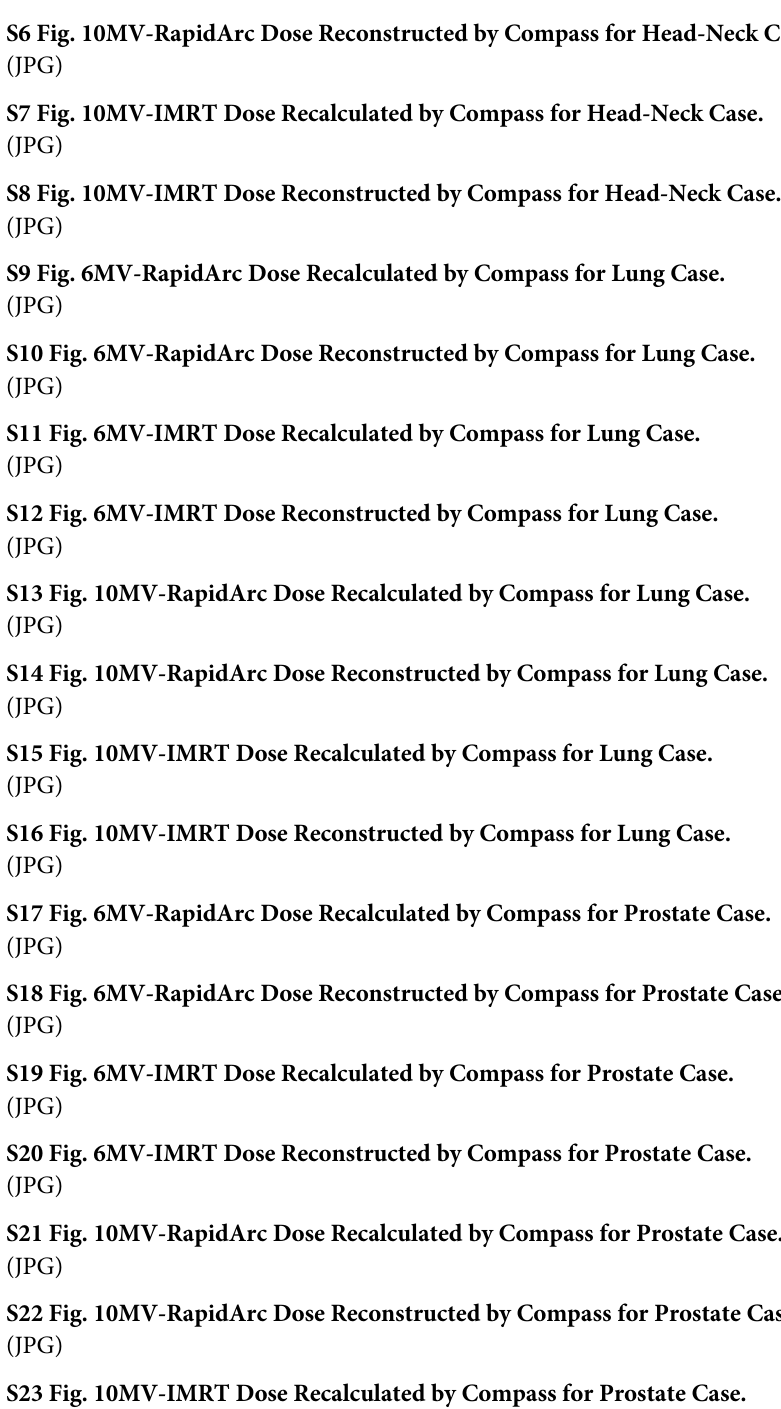
(JPG) S6 Fig. 10MV-RapidArc Dose Reconstructed by Compass for Head-Neck Case. (JPG) S7 Fig. 10MV-IMRT Dose Recalculated by Compass for Head-Neck Case. (JPG) S8 Fig. 10MV-IMRT Dose Reconstructed by Compass for Head-Neck Case. (JPG) S9 Fig. 6MV-RapidArc Dose Recalculated by Compass for Lung Case. (JPG) S10 Fig. 6MV-RapidArc Dose Reconstructed by Compass for Lung Case. (JPG) S11 Fig. 6MV-IMRT Dose Recalculated by Compass for Lung Case. (JPG) S12 Fig. 6MV-IMRT Dose Reconstructed by Compass for Lung Case. (JPG) S13 Fig. 10MV-RapidArc Dose Recalculated by Compass for Lung Case. (JPG) S14 Fig. 10MV-RapidArc Dose Reconstructed by Compass for Lung Case. (JPG) S15 Fig. 10MV-IMRT Dose Recalculated by Compass for Lung Case. (JPG) S16 Fig. 10MV-IMRT Dose Reconstructed by Compass for Lung Case. (JPG) S17 Fig. 6MV-RapidArc Dose Recalculated by Compass for Prostate Case. (JPG) S18 Fig. 6MV-RapidArc Dose Reconstructed by Compass for Prostate Case. (JPG) S19 Fig. 6MV-IMRT Dose Recalculated by Compass for Prostate Case. (JPG) S20 Fig. 6MV-IMRT Dose Reconstructed by Compass for Prostate Case. (JPG) S21 Fig. 10MV-RapidArc Dose Recalculated by Compass for Prostate Case. (JPG) S22 Fig. 10MV-RapidArc Dose Reconstructed by Compass for Prostate Case. (JPG) S23 Fig. 10MV-IMRT Dose Recalculated by Compass for Prostate Case. (JPG) S24 Fig. 10MV-IMRT Dose Reconstructed by Compass for Prostate Case.